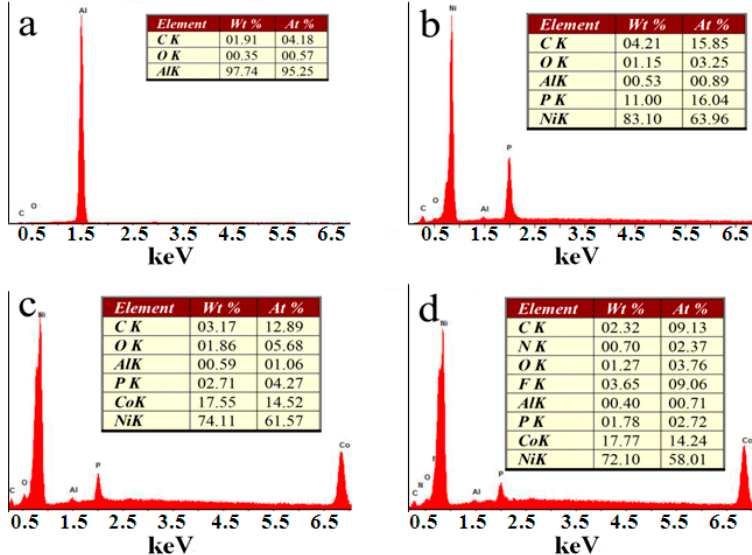
Figure 4. Energy dispersive X-ray spectrum (EDS) spectra and its corresponding element content. ( a ) bare aluminum alloy; ( b ) electroless Ni coating; ( c ) electrodeposited Ni–Co plating; ( d ) superhydrophobic surface after modified AF17N.